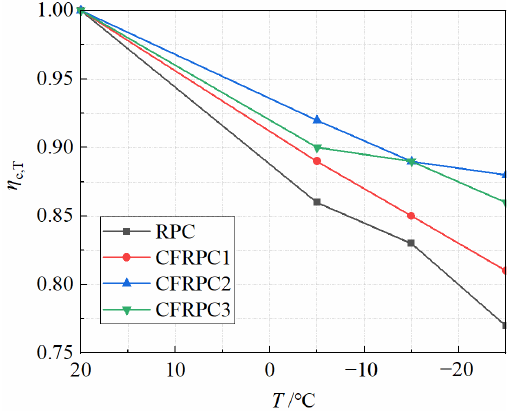
Figure 11. Relationship η c,T vs. T.